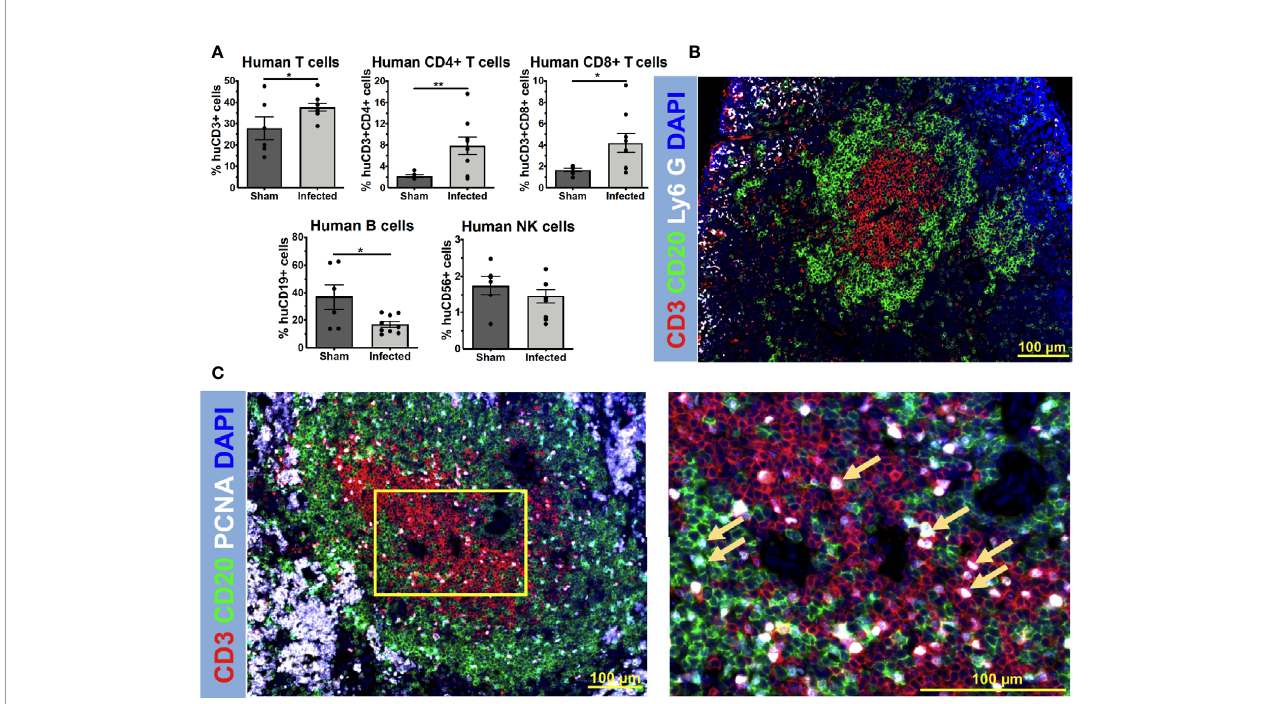
FIGURE 1 | S. aureus elicits a human immune response in humanized NSG mice. HuNSG mice received a sterile (Sham) or MRSA contaminated transtibial implant, and 14 days post infection, mice were euthanized, and spleens were harvested for analyses. Single-cell suspensions of splenocytes were prepared and subjected to immunophenotyping analyses by fl ow cytometry with anti-human mAbs to assess human T cells (CD3+), T helper cells (CD3+CD4+), cytotoxic T cells (CD3+CD8+), B cells (CD19+), and NK cells (CD56+). The sequential gating strategy is depicted in Supplemental Figure S1 . (A) The percentage of each lymphocyte subset of the live/human CD45+ cells analyzed is presented for each mouse with the mean +/- SD for the group (n = 15, * p < 0.05, ** p < 0.01, t-test). (B) Paraf fi n-embedded 5 m m spleen sections from infected humanized NSG mice were stained to visualize the spatial distribution of human CD3 + T cells (red), human CD20 + B cells (green), and murine Ly6G + neutrophils (white). Representative 3x3 200x mosaic immuno fl uorescent images are shown highlighting the compartmentalization of interacting human T and B cells in spleens of infected huNSG mice. (C) Adjacent 5 m m spleen sections were also stained for examining cell proliferation in response to S. aureus infections using proliferating cell nuclear antigen (PCNA) (white). Yellow squares show higher magni fi cation images of proliferating CD3 + T cells (red), CD20 + B cells (green) (PCNA+ cells, yellow arrows), in the sections of the 3x3 mosaic immuno fl uorescent